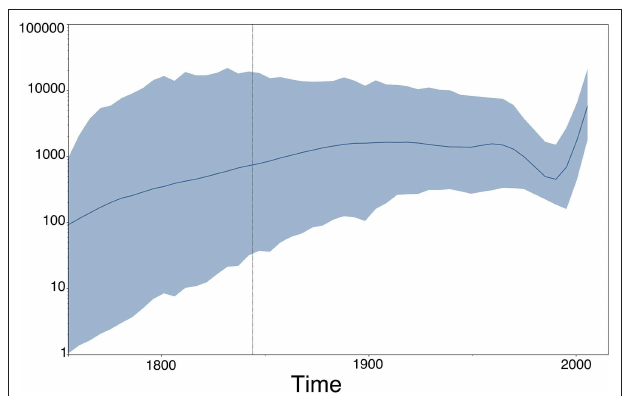
FIGURE 8 | Population (size) dynamics over time visualization of our RABV analysis (previous section) using Tracer (49). This type of output does not directly depend upon the estimated MCC tree, but rather on the estimated (log) population sizes of the Skygrid model (50), which are provided in a separate output file by BEAST